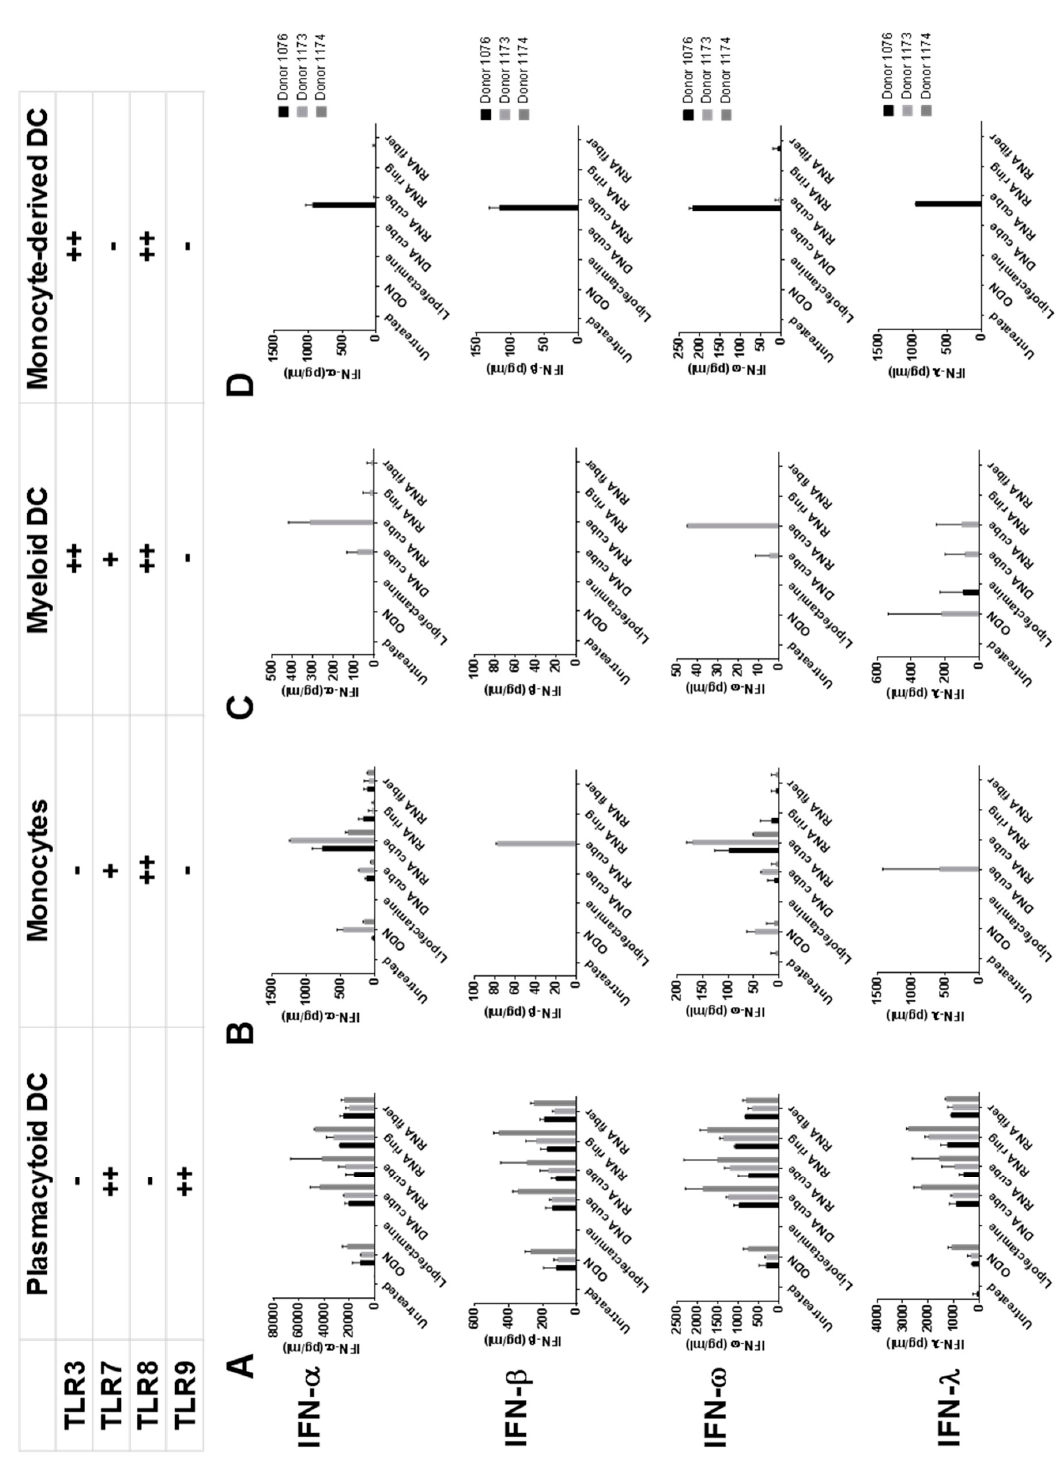
Figure 2. The response of dendritic cell (DC) subsets to delivered NANPs. NANPs were delivered to cells from major DC subsets purified by negative selection, and resulting supernatants were assayed for IFN production. The purified DC subsets tested were ( A ) plasmacytoid DCs, ( B ) monocytes, and ( C ) myeloid DCs. Additionally, isolated monocytes were differentiated into ( D ) monocyte-derived DCs, which were also tested for IFN induction. Some data from individual donors presented in this figure were adapted from our earlier study [33] with permission. ODN = ODN2216, an oligonucleotide, known to induce interferon response and used in our study as a positive